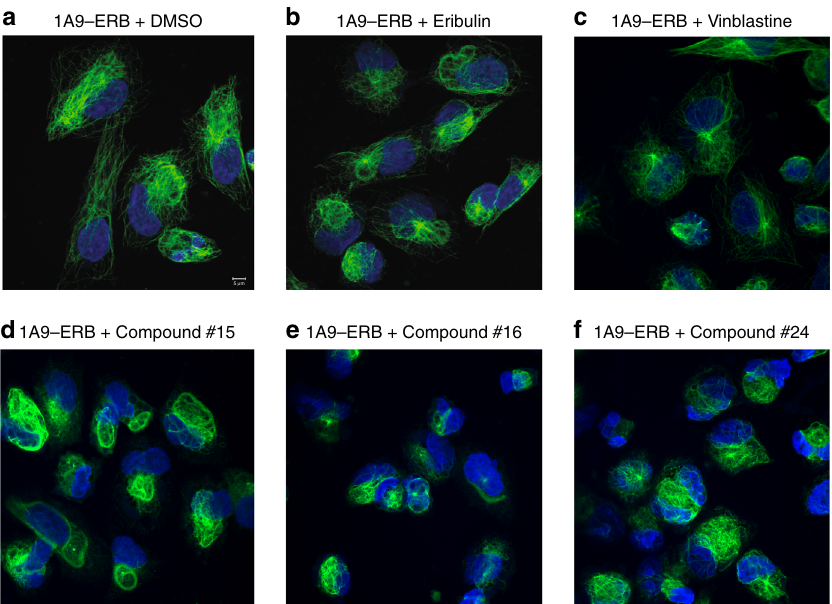
Fig. 4 BANDIT predicted small molecules can act on resistant cells. Effect of various compounds on the microtubule integrity of 1A9-ERB cells after 6 h of treatment: a Control with DMSO (Scale bar: 5 μ m), 100 nM of b Eribulin and c Vinblastine, and 1 μ M of d Compound #15, e Compound #16